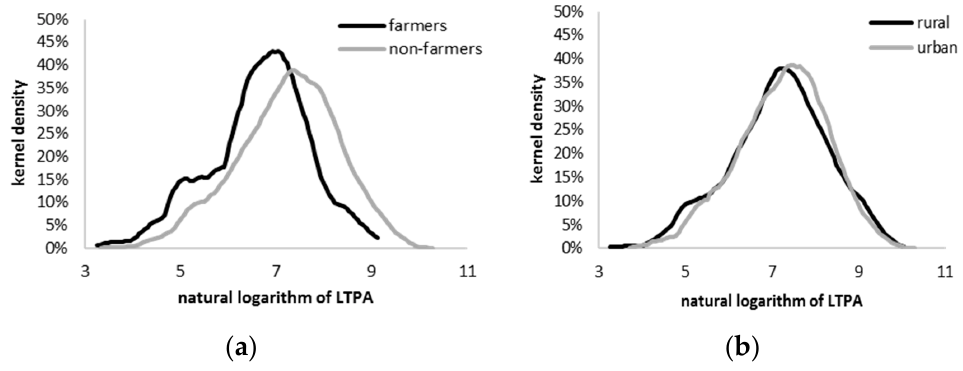
Figure 1 . Distribution of physical activity: farming vs. others ( a ) and inhabitants of rural areas vs. others ( b ). Notes: (1) x-axis: natural logarithm of physical activity measured in MET-min; (2) For the sake of clarity and to improve fit we present kernel densities for individuals with non-zero LTPA.